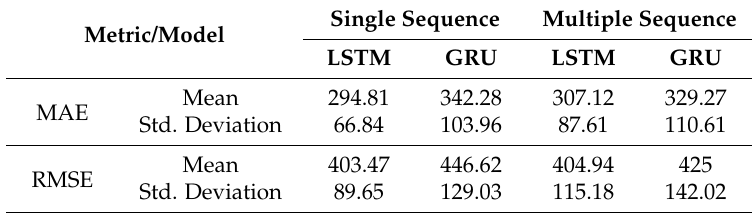
Figure 17 . Time series cross validation with multiple Train-Test Splits. Table 5. Performance Metrics for single and multiple-sequence models using time series split. Table 5. Performance Metrics for single and multiple-sequence models using time series split. Table 5. Performance Metrics for single and multiple-sequence models using time series split.